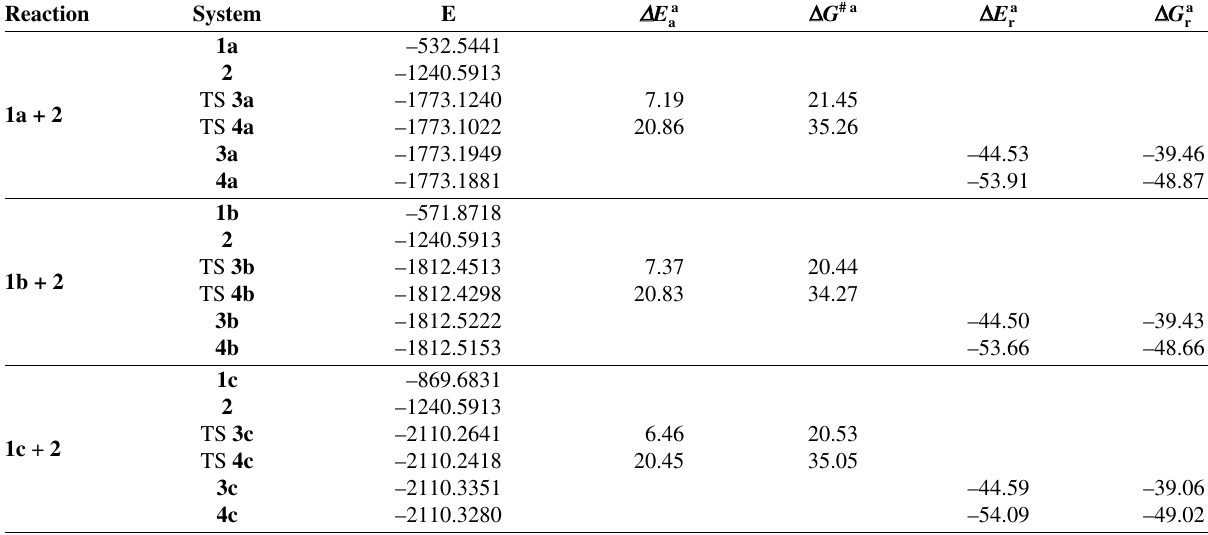
(kcalmol –1 ), relative a (kcalmol –1 ). r